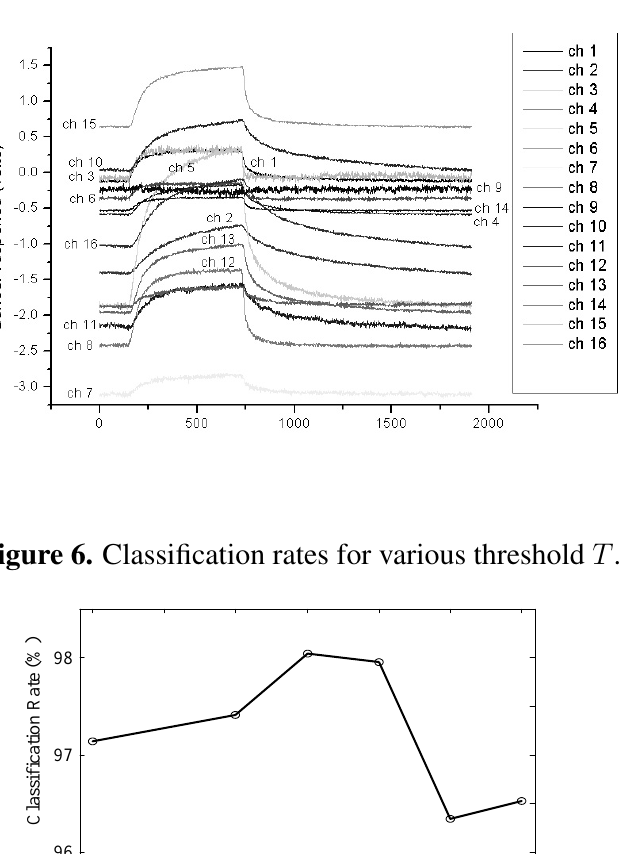
Figure 5. Typical time-responses of 16 channel sensor array with respect to inflow of acetone vapor at 5,000 ppm.